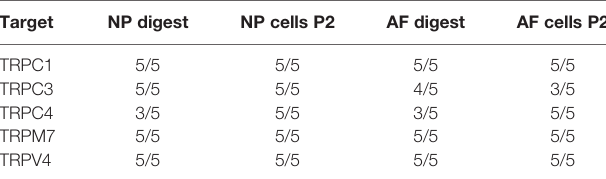
( Table 1 ) were employed to test whether their activity differs between iso- and hypo-osmotic conditions. To ensure non-toxicity